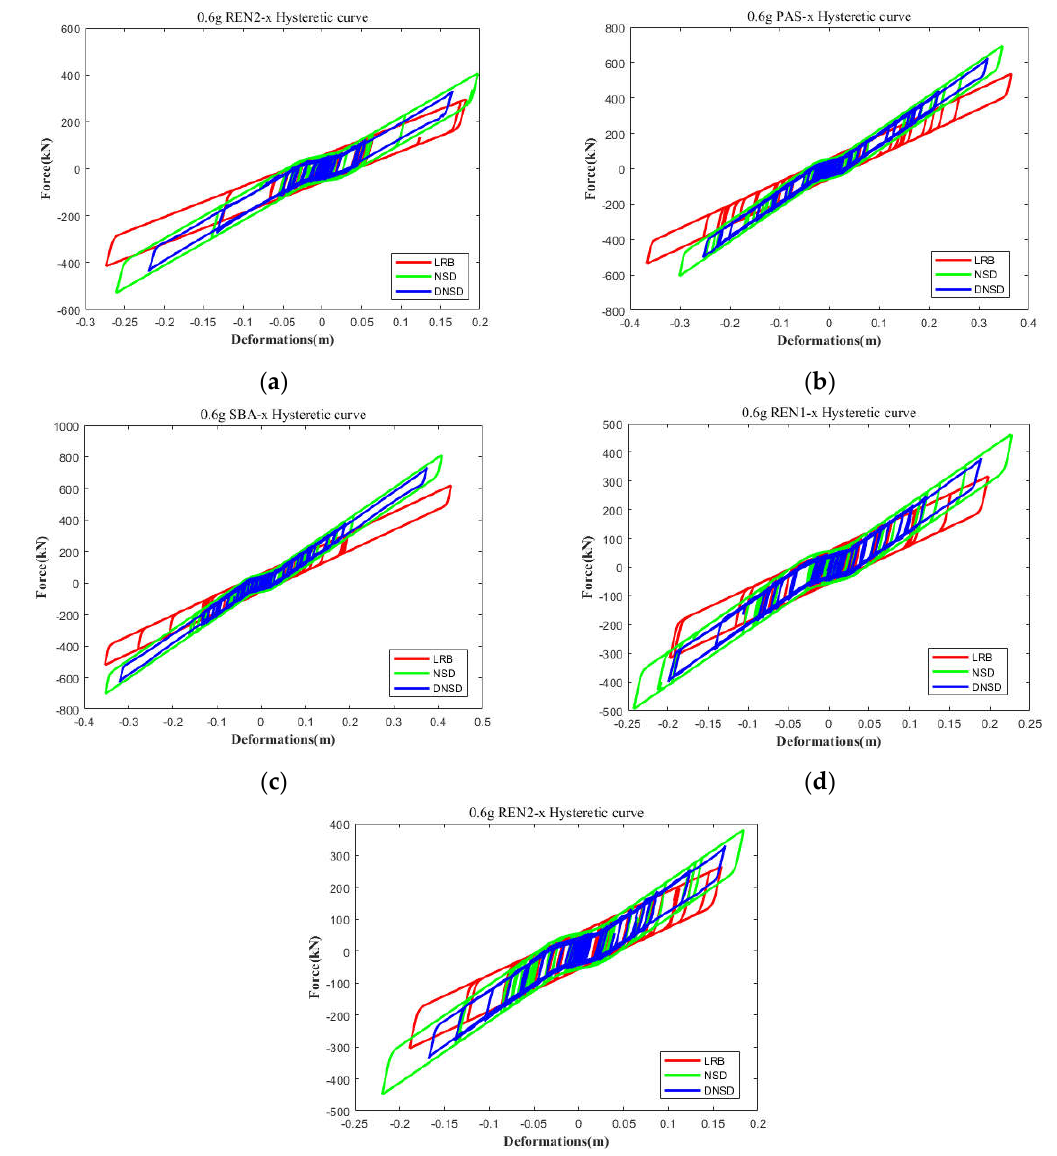
Figure 25. Comparison of hysteretic curves among three models under different earthquake waves at a peak of 0.6 g. ( a ) Hysteresis loops under EL seismic wave at peak of 0.6 g. ( b ) Hysteresis loops under PAS seismic wave at peak of 0.6 g. ( c ) Hysteresis loops under SBA seismic wave at peak of 0.6 g. ( d ) Hysteresis loops under REN1 seismic wave at peak of 0.6 g. ( e ) Hysteresis loops under REN2 seismic wave at peak of 0.6 g.